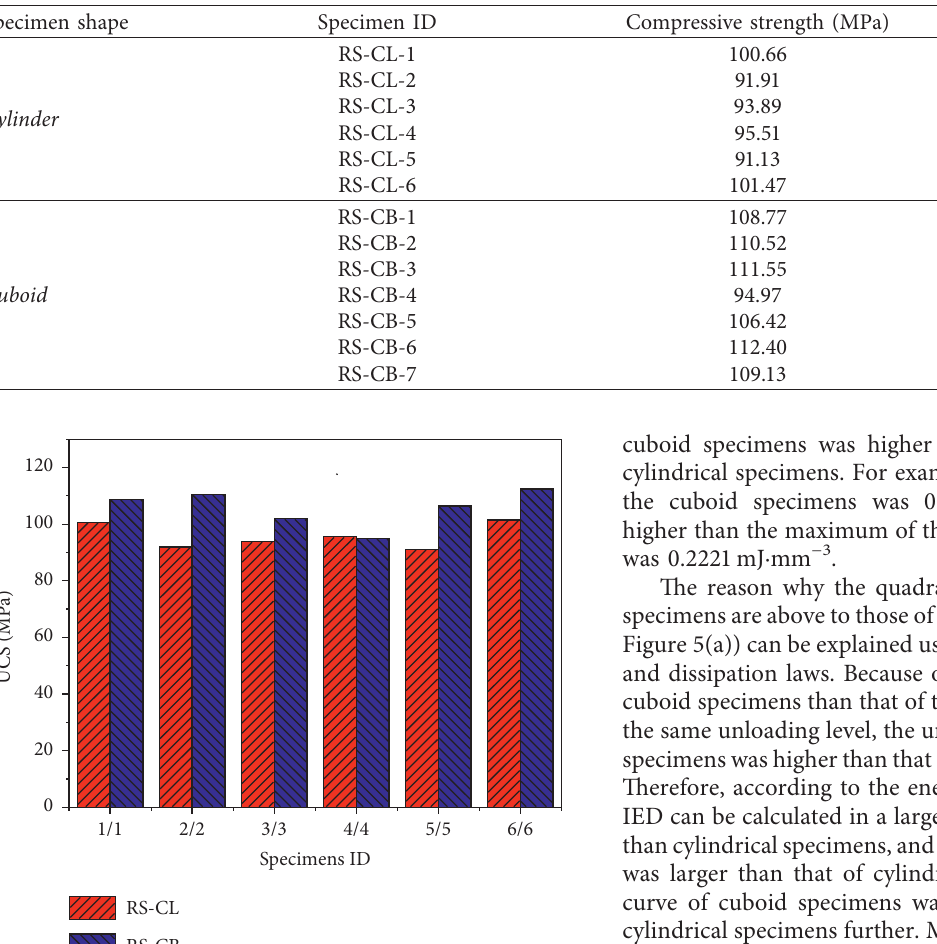
Table 2: UCS of cylindrical and cuboid specimens.